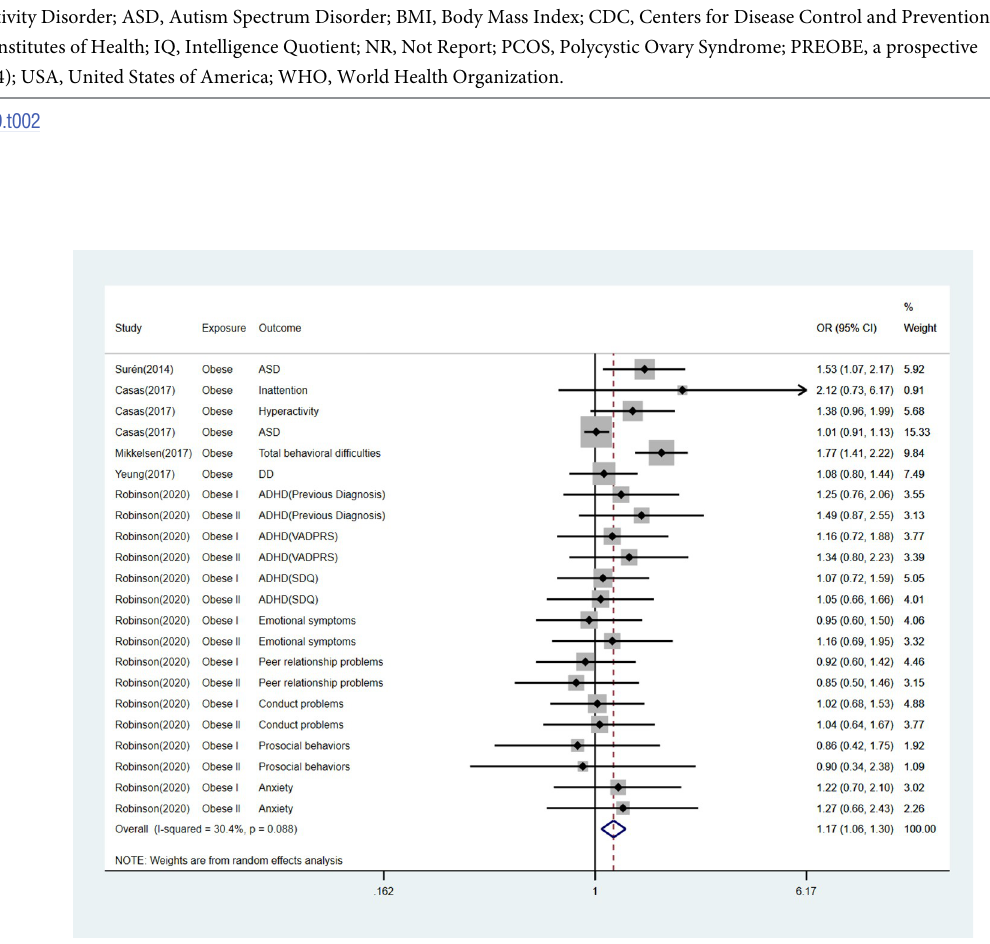
Fig 2. Forest plot for obese fathers and their offspring’s risk of any mental